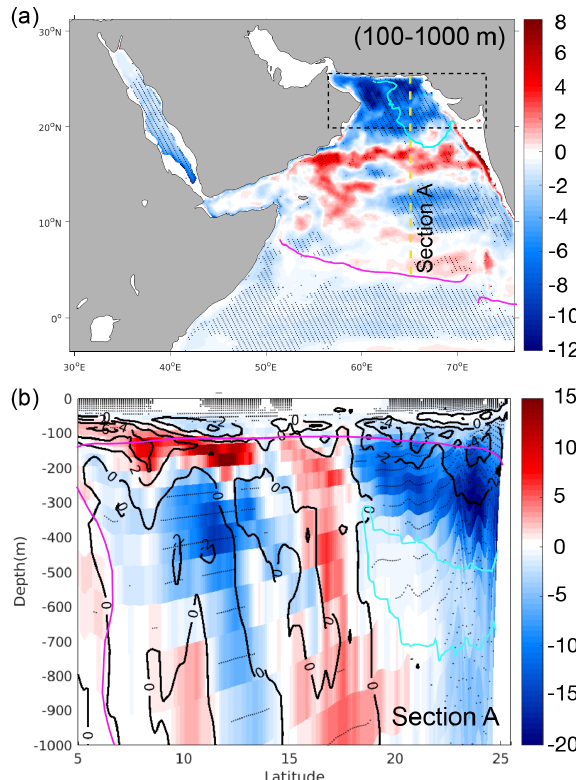
Figure 4. Deoxygenation rates in the AS between 1982 and 2010. (a) Trends in O 2 inventories (in percent per decade) in the 100– 1000m layer. The dashed black rectangle indicates the location of the northern AS box. The dashed yellow line indicates section A. (b) Trends (color shading; in percent per decade) and changes be- tween the first 5 years (1982–1986) and the last 5 years (2006– 2010) (contour lines; in mmolm − 3 per decade) in O 2 in the upper 1000m along section A at 65 ◦ E (in percent per decade). Statisti- cally significant trends at the 95% confidence interval following a Mann–Kendall (MK) test are represented by hatching (a) and stip- pling (b) . The purple and cyan lines indicate the average positions of the hypoxic (O 2 < 60mmolm − 3 ) and suboxic (O 2 < 4mmolm − 3 ) boundaries, respectively, at (a) 500m and (b) along section A. Rel- ative trends (in percent per decade) were obtained by dividing the absolute trends by the local mean O 2 inventory (a) or concentration (b)